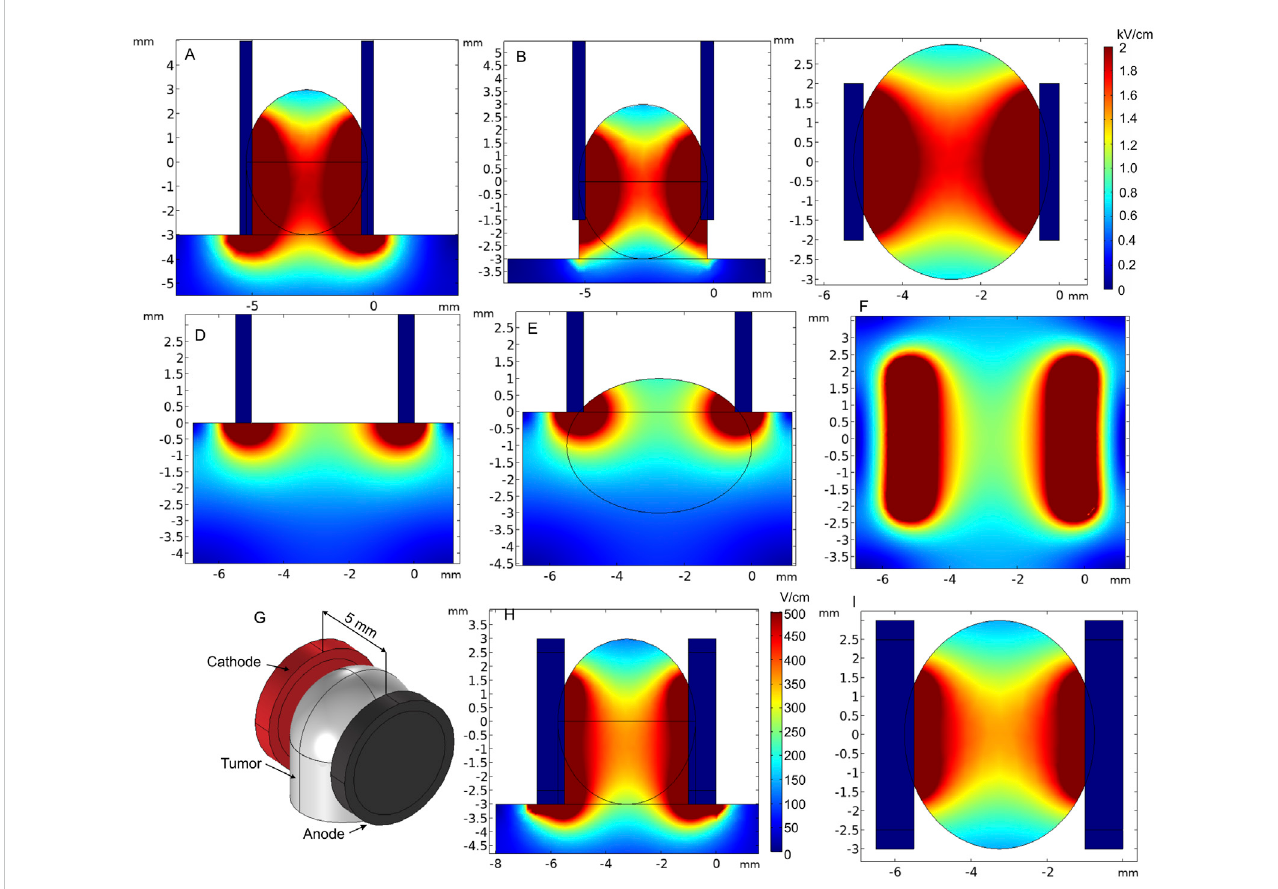
FIGURE 10 Spatial electric fi eld distribution of plate and round tweezer electrodes using 1000 V and 200 V terminal voltages, respectively. (A) Electroporation of a super fi cial tumor, when plates embrace the tumor suf fi ciently, side view; (B) electroporation of a super fi cial tumor, when plates embrace the tumor insuf fi ciently, side view; (C) electroporation of the super fi cial tumor, top view; (D) electroporation of the skin, side view; (E) electroporation of melanoma or a small super fi cial tumor; (F) electroporation of the skin or melanoma, top view; (G) round tweezer electrode simulation model; (H) spatial electric fi eld distribution, side view; (I) spatial electric fi eld distribution, top